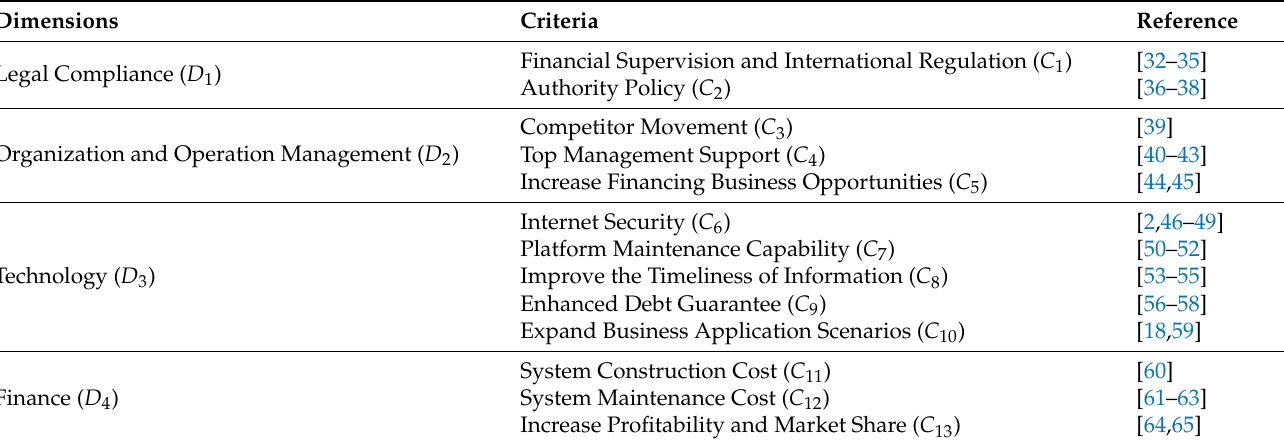
Table 2. The following DEMATEL analysis involves the same 12 experts. Table 2. Summary of dimensions and criteria.